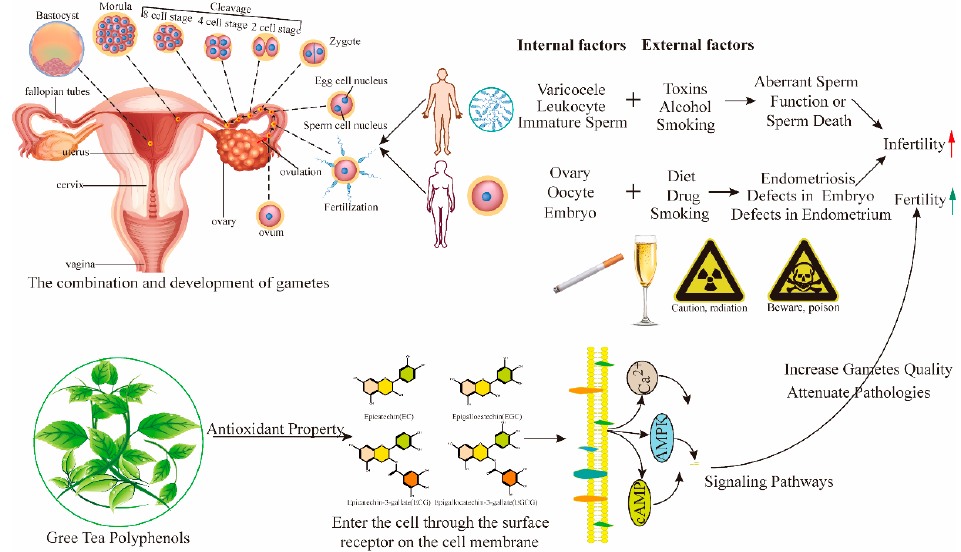
Figure 2. Action of green tea polyphenols on major fertility reducing factors. Various internal and external factors impair sperm function and/or cause sperm death, whereas in females, they disrupt gamete and embryo development. AMPK, adenosine monophosphate-activated protein kinase; cAMP, cyclic adenosine monophosphate; Ca 2+ , calcium ion.